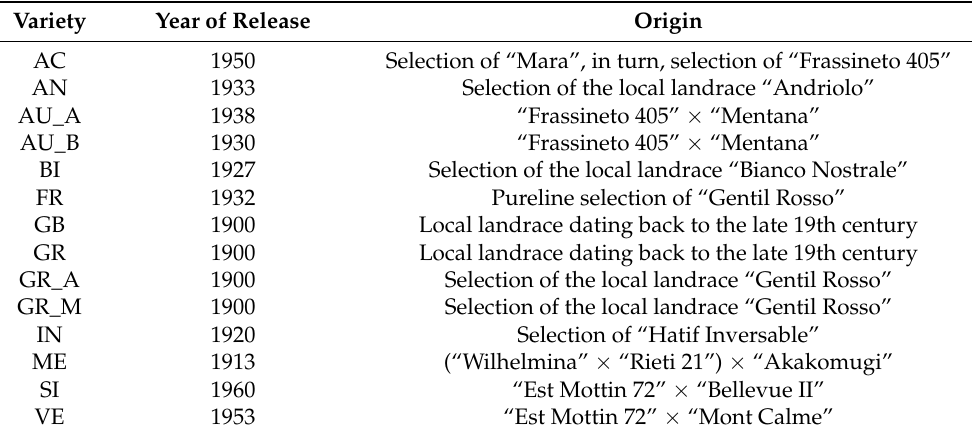
Table 2. Release year and origin for the wheat cultivars used in this study. Data were obtained from the website of the seed bank in the Tuscany Region